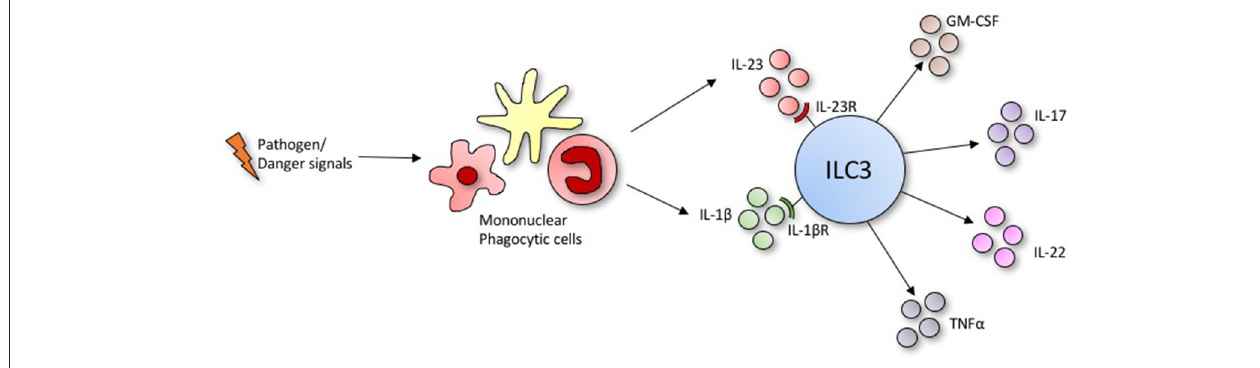
FIGURE 1 | Under conditions of stress or infection, ILC3s produce an array of effector cytokines in response to activating ligands secreted by phagocytic mononuclear cells.